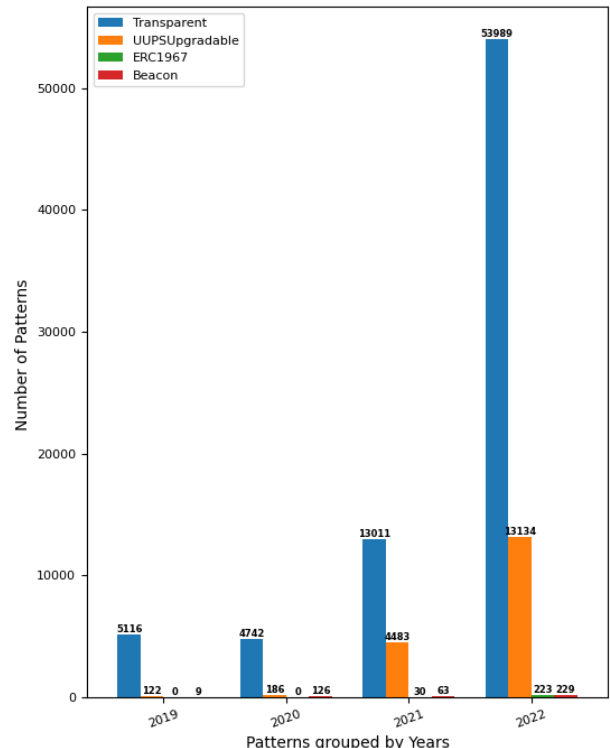
Figure 10 Number of Upgradeable patterns between 2019